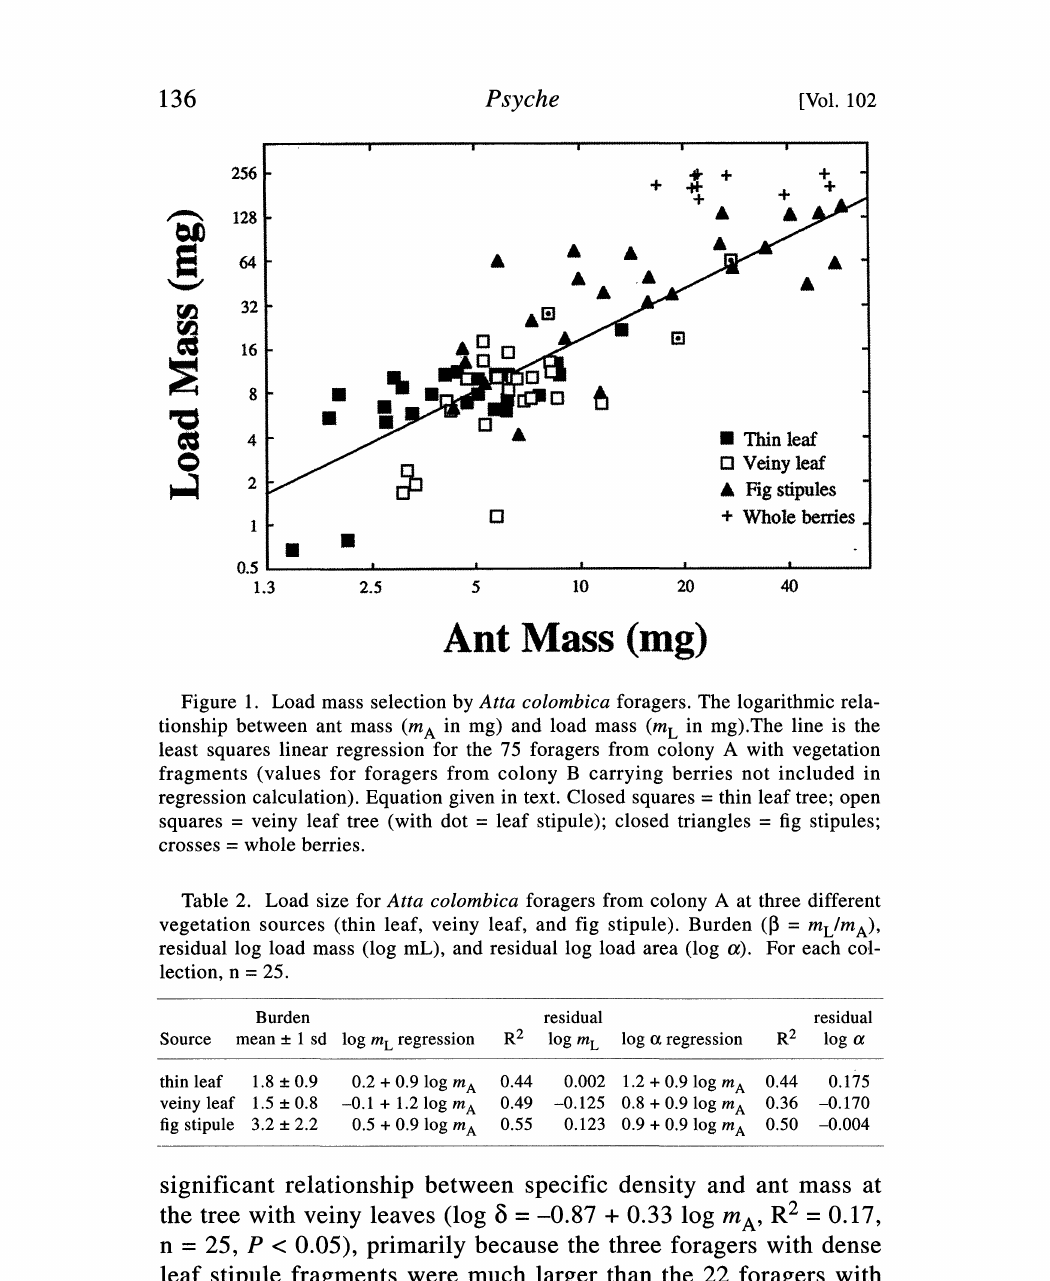
fig stipule 3.2 +/-